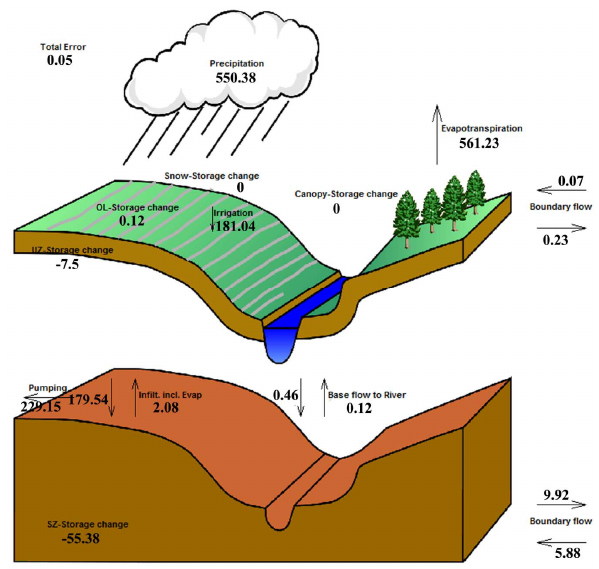
Fig.11. Graphical water balance result of the entire NCP aquifer system. The numbers in the 1057 Fig. 11. Graphical water balance result of the entire NCP aquifer figure are normalized annual averaged values in the type of storage depth with unit of 1058 system. The numbers in the figure are normalized annual averaged mm/year. 1059 values in the type of storage depth with unit of mmyr − 1 .